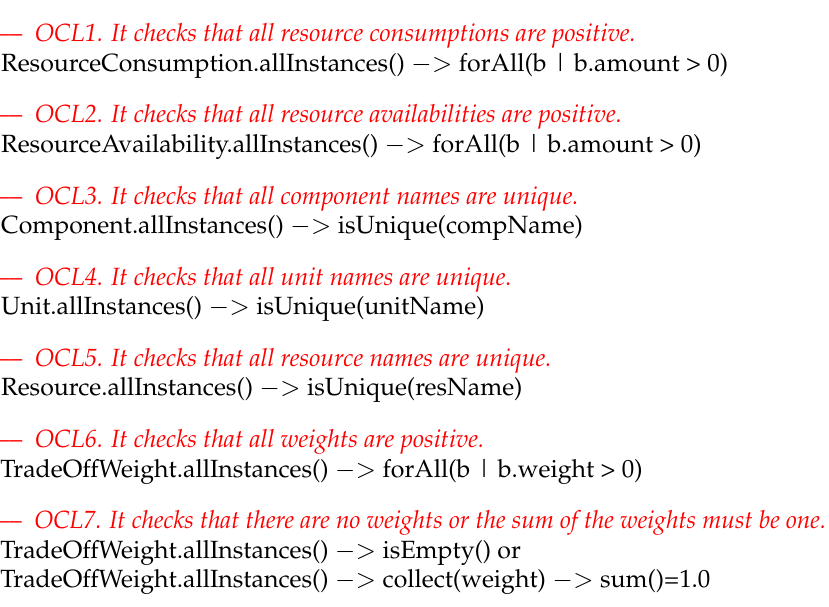
Figure 6. OCL assertions for the CAP